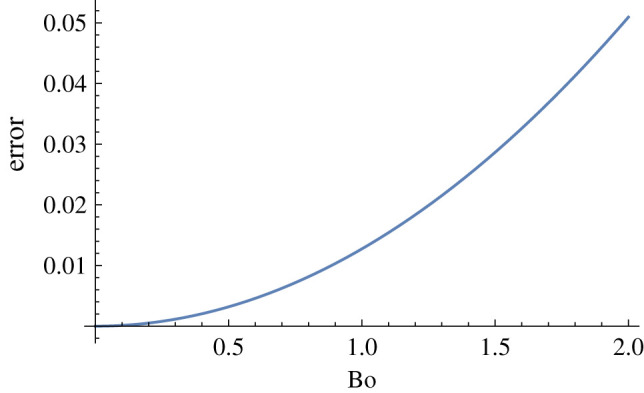
The estimation of error of −H~0 versus Bo for α = 45° and θ0 = 120°.